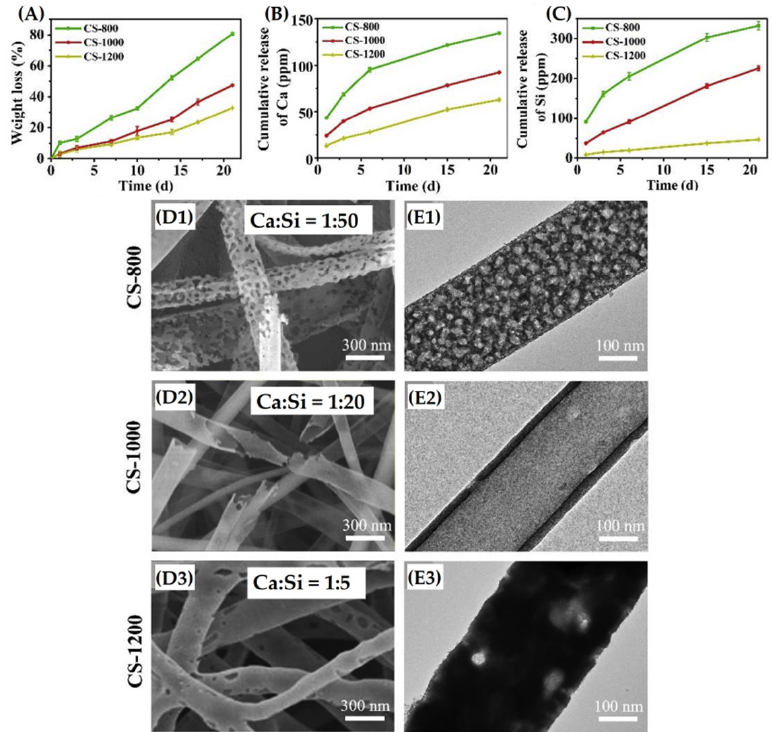
Figure 10. ( A ) Weight loss, cumulative release of ( B ) calcium ions and ( C ) silicate ions from sintered nanofibers of CS-800, CS-1000, and CS-1200; ( D1 – D3 ) shows SEM images and ( E1 , E3 ) TEM images of the corresponding calcium silicate nanofibers, after degradation in deionized water at 37 °C for 21 days; ( D1,E1 ) corresponding to CS-800 composition; ( D2,E2 ) corresponding to CS-1000 and ( D3 , E3 ) to CS-1200. Reprinted from [170], copyright (2019), with permission from Ceramics Inter- national.